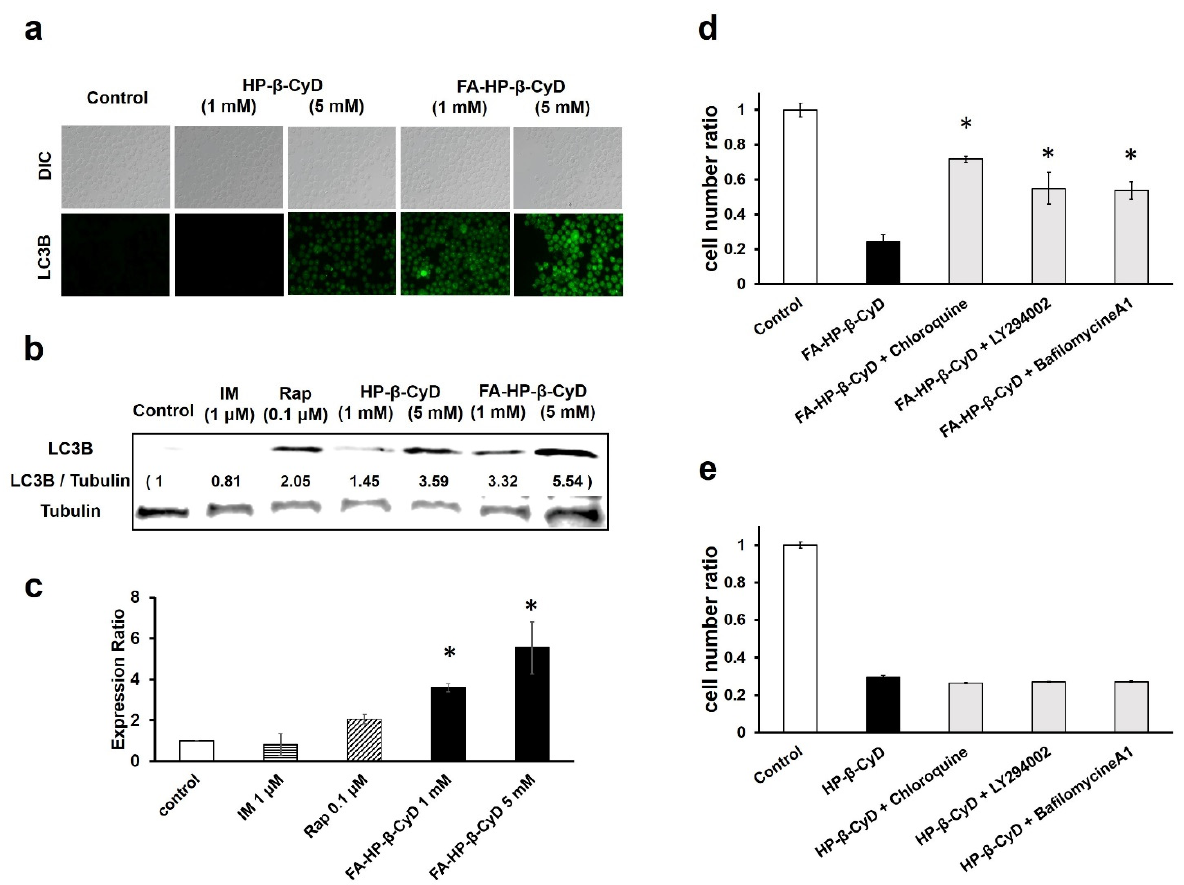
Figure 6. Induction of autophagy by treatment with FA-M- β -CyD. ( a ) Detection of autophagy in CML cells. K562 cells treated with FA-HP- β -CyD and HP- β -CyD for 2 h were exposed to Cyto-ID for 30 min. For observation, fluorescence microscopy was used. ( b ) Effect of HP- β -CyDs on LC3B expression in K562 cells. Cells were treated with medium only (control), FA-HP- β -CyD, HP- β -CyD, imatinib (IM), and rapamycin (Rap) for 2 h. LC3B protein levels were detected by western blotting. ( c ) The graph shows the fluorescence intensity of the bands. * p < 0.05 compared with the control. ( d and e ) Effects of chloroquine, bafilomycin A1, and LY294002 on the antitumor activity of FA-HP- β -CyD ( d ) and HP- β -CyD ( e ) in BV173 cells. Cells were incubated for 24 h. * p < 0.05 compared with FA-HP- β -CyD.